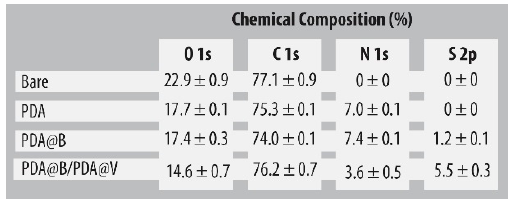
Figure A1. Plots of different initial weights of samples against the residual weights at 800 °C for both PDA ( a ) and PCL/HA scaffolds ( b ).